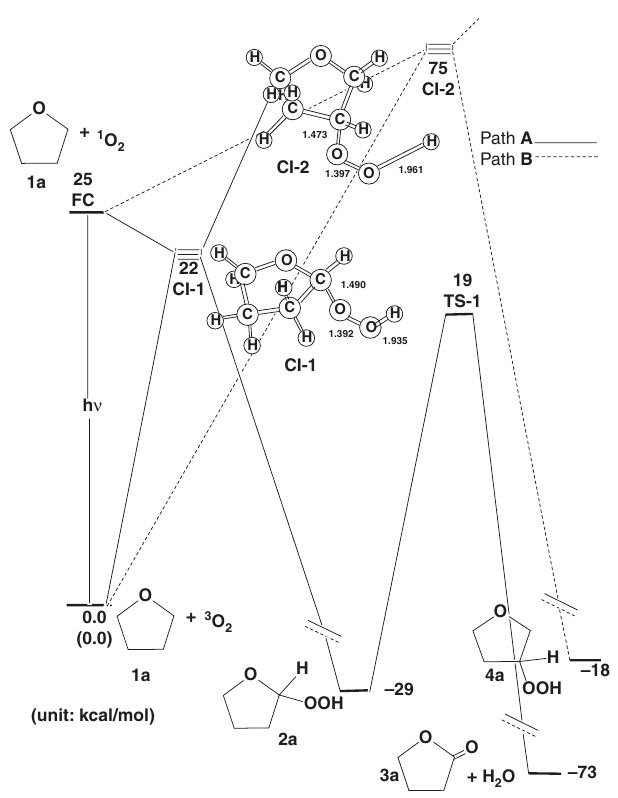
Fig. 4 Theoretical calculated energy diagram. Theoretical calculations of direct singlet oxygen insertion into α and β C – H bonds of THF adjacent to the ethereal oxygen were carried out using the CAS-MP2(20,14)/6-311 G (p)//CAS(20,14)/6-31 G(p) method